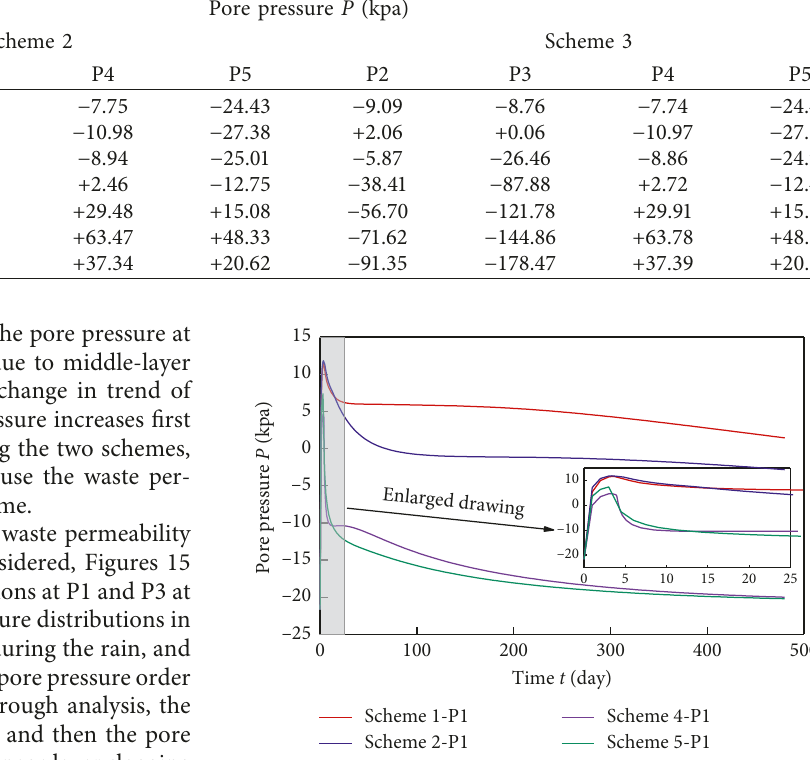
Figure 15: Variation curves of the pore pressure at P1 with time in four schemes.